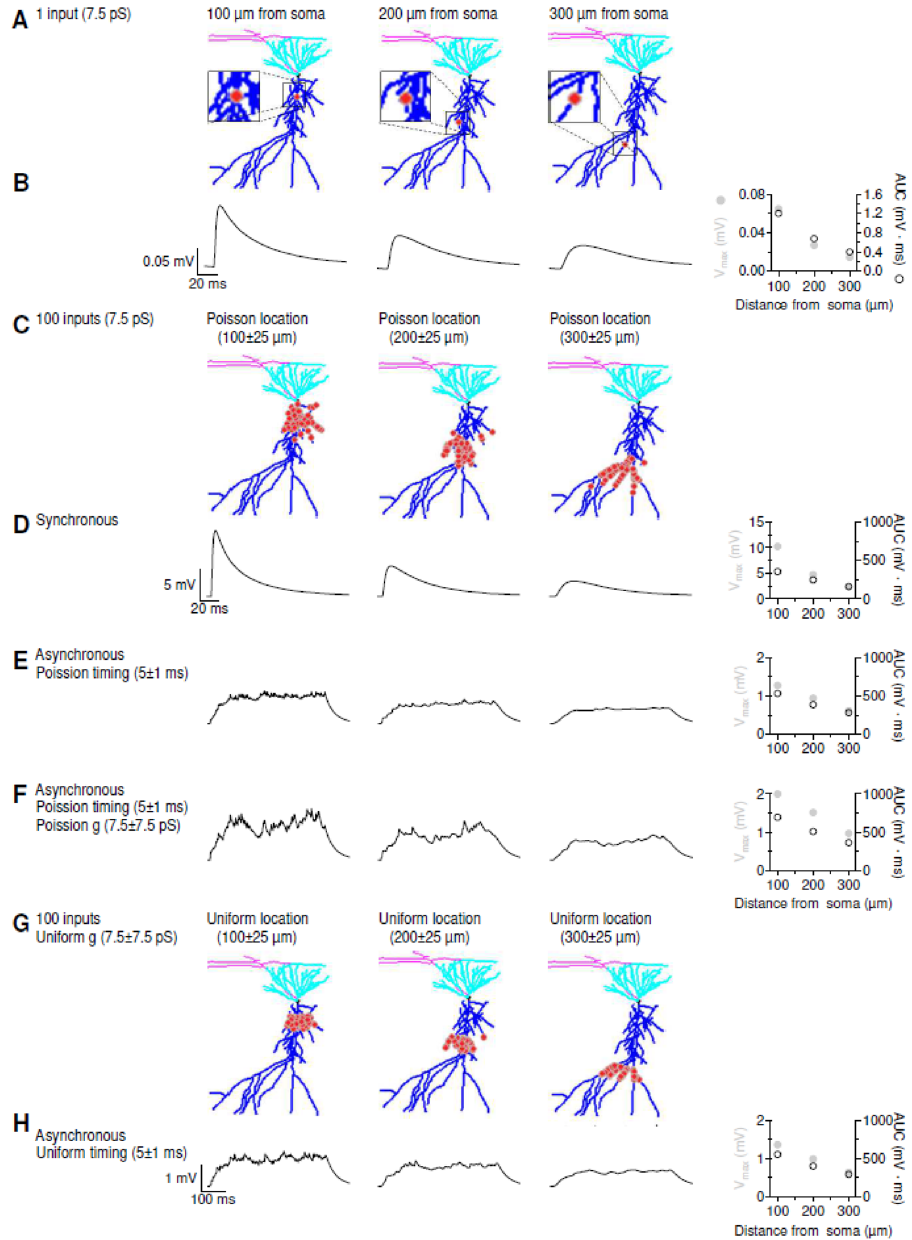
Figure 4. Sample Application of NRN-EZ for summation of sub-threshold EPSPs. ( A ) We used NRN-EZ to place one AMPA excitatory input at 100–300 µm from the soma of a 3D reconstructed, biocytin-filled CA1- PCs. The maximum intensity projection of the CA1-PC includes the soma ( black ), basal dendrites ( cyan ), apical dendrites ( blue ) and the location of the input ( red ). The synaptic weight was set to 7.5 pS. ( B ) Somatic recording obtained using the NEURON simulation environment. The maximum depolarization (V max ) and the AUC of the somatic EPSP for increasing distances from the soma are plotted in the right panel. ( C ) As in A, for 100 inputs with a Poisson placement along the distal dendrite of the CA1-PC. ( D ) As in B, in response to the synchronous activation of the 100 inputs described in C. ( E ) Somatic EPSPs recorded in response to the asynchronous activation of the 100 excitatory inputs described in C. ( F ) As in E, for synaptic inputs with a Poisson conductance distribution. ( G ) As in C, for 100 inputs with a uniform spatial distribution centered 100–300 µm away from the soma. ( H ) As in F, for 100 inputs with uniform spatial distribution and uniform timing of